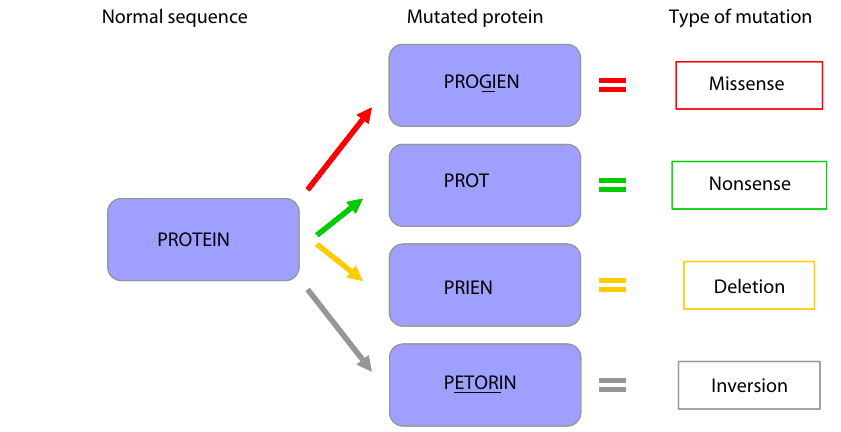
Figure 8. Different types of mutation and possible conseuquence on protein function: A) missense mutation; B) nonsense mutation; C) deletion; D) inversion. D) amplifications leading to multiple copies of chromosomal regions and consequently to